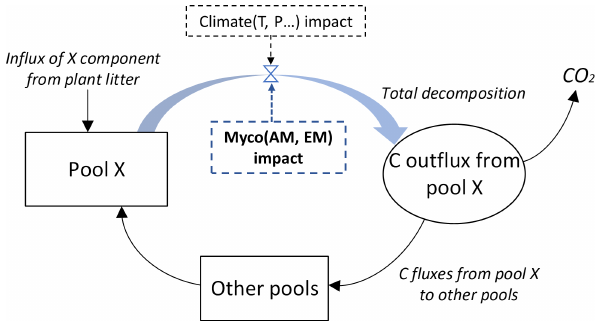
Figure 2. Carbon fluxes from and to each X pool of carbon, with X being W , A , E , or N , as represented by the modified Yasso model. The blue arrow and blue box show conceptualization of the added impact of the mycorrhizal environment on the litter decomposition process. While in the original version of the Yasso model plant lit- ter decomposition process was represented as a function of climate and litter quality, in our model decomposition is a function of pro- portions of ectomycorrhizal and arbuscular mycorrhizal plants in vegetation, climate, and plant litter